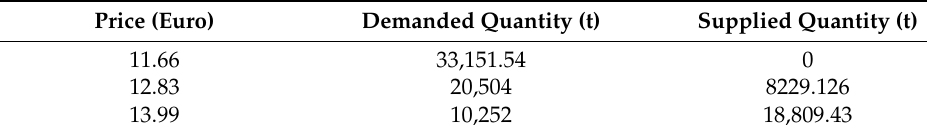
Table 7. Integrated model output for gmina (Obsza) 060210.